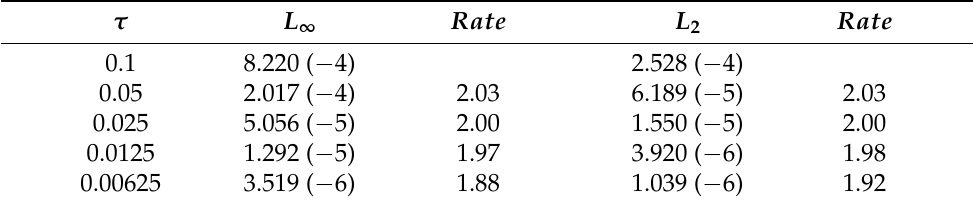
Table 8. The L ∞ error and L 2 error when h = 1